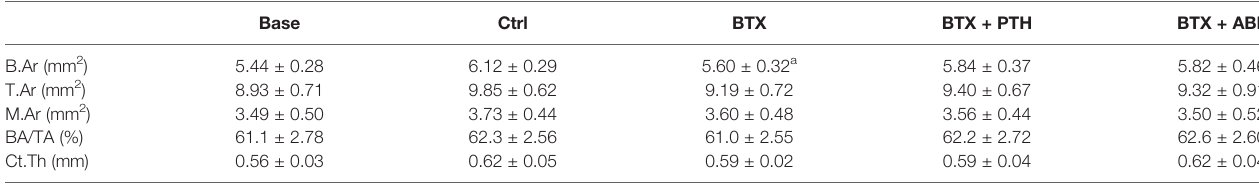
TABLE 2 | Microstructural properties of the right femoral mid-diaphysis from rats with the right hindlimb immobilized with BTX and treated with PTH or ABL. Base Ctrl BTX BTX + PTH